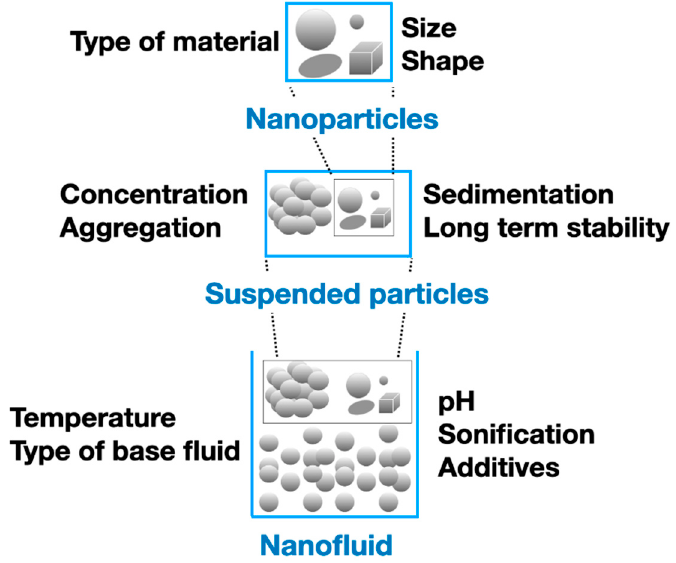
Figure 1. Different features that may affect the stability of nanofluids, adapted from [37].